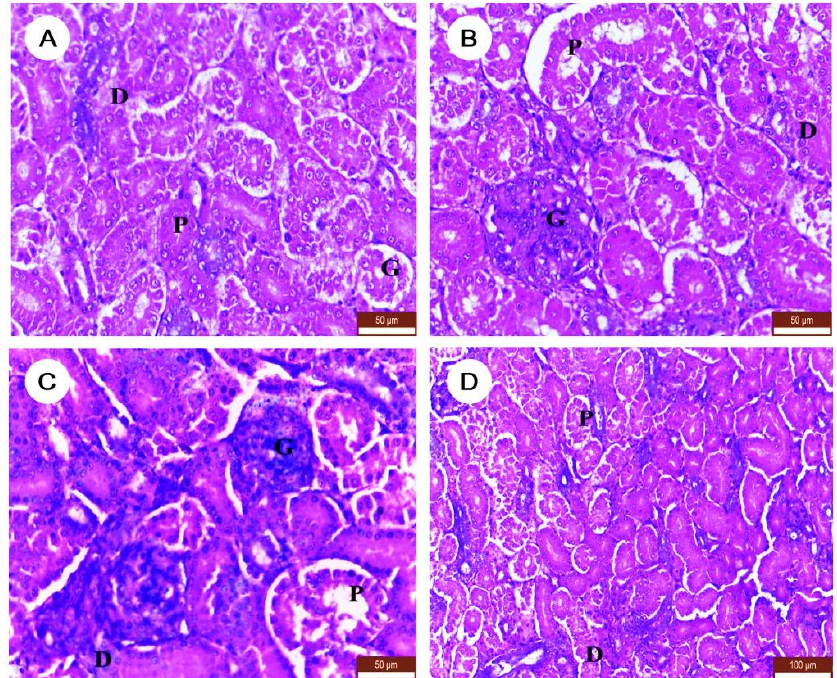
Figure 6. Changes in the kidney histopathology after treatment with DLM and/or NAC. ( A ) Control group (scale bar = 50 µm), ( B ) NAC group (scale bar = 50 µm), ( C ) DLM (scale bar = 50 µm); and ( D ) DM+NAC (scale bar = 100 µm). G: Glomerulus, P: proximal tubule, D: distal tubule (H&E stain).